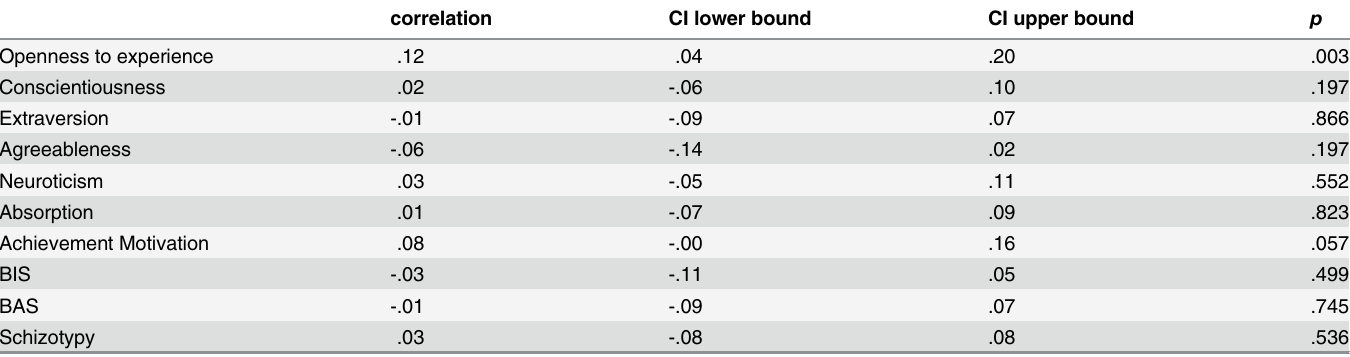
Table 4. Correlations of noticing with the personality